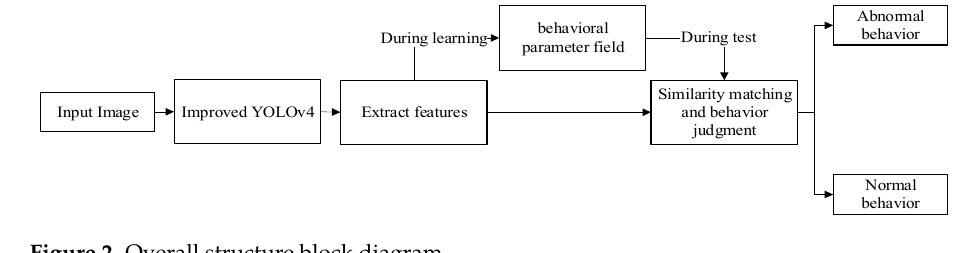
Figure 2. Overall structure block diagram.